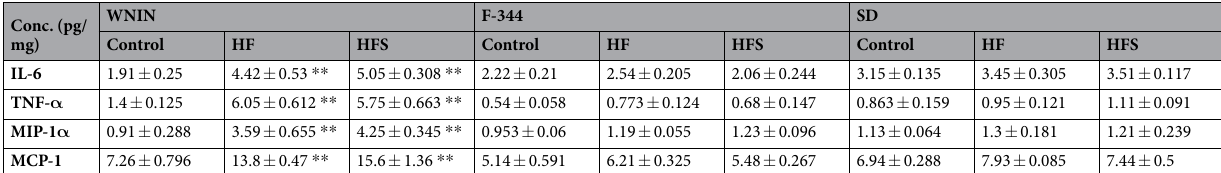
Table 1. Expression of pro-inflammatory cytokines in visceral adipose tissue. Retroperitoneal fat was used for the preparation of total tissue lysate and estimated the protein levels of pro-inflammatory cytokines such as interleukin 6, IL-6; tumor necrosis factor alpha, TNF α ; macrophage inflammatory protein 1 alpha, MIP-1 α ; monocyte chemotactic protein 1, MCP1 among WNIN, F-344 and SD rats under high calorie environment. Data was presented as mean ± SEM (n = 6 per group). Diets: control; HF, high fat; HS, high sucrose; HFS, high fat sucrose. * P < 0.05; ** P < 0.01; *** P < 0.001 statistically significance compared to their respective controls. Groups were compared using one way